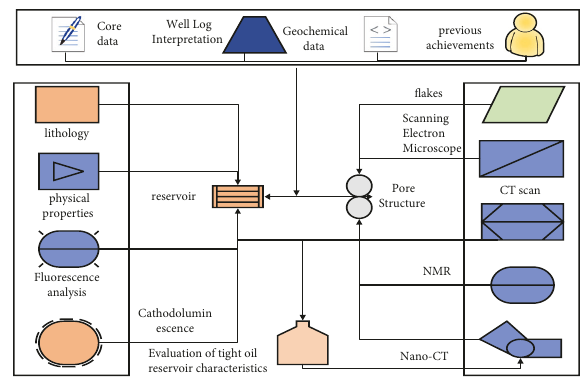
Figure 1: Evaluation route of tight oil